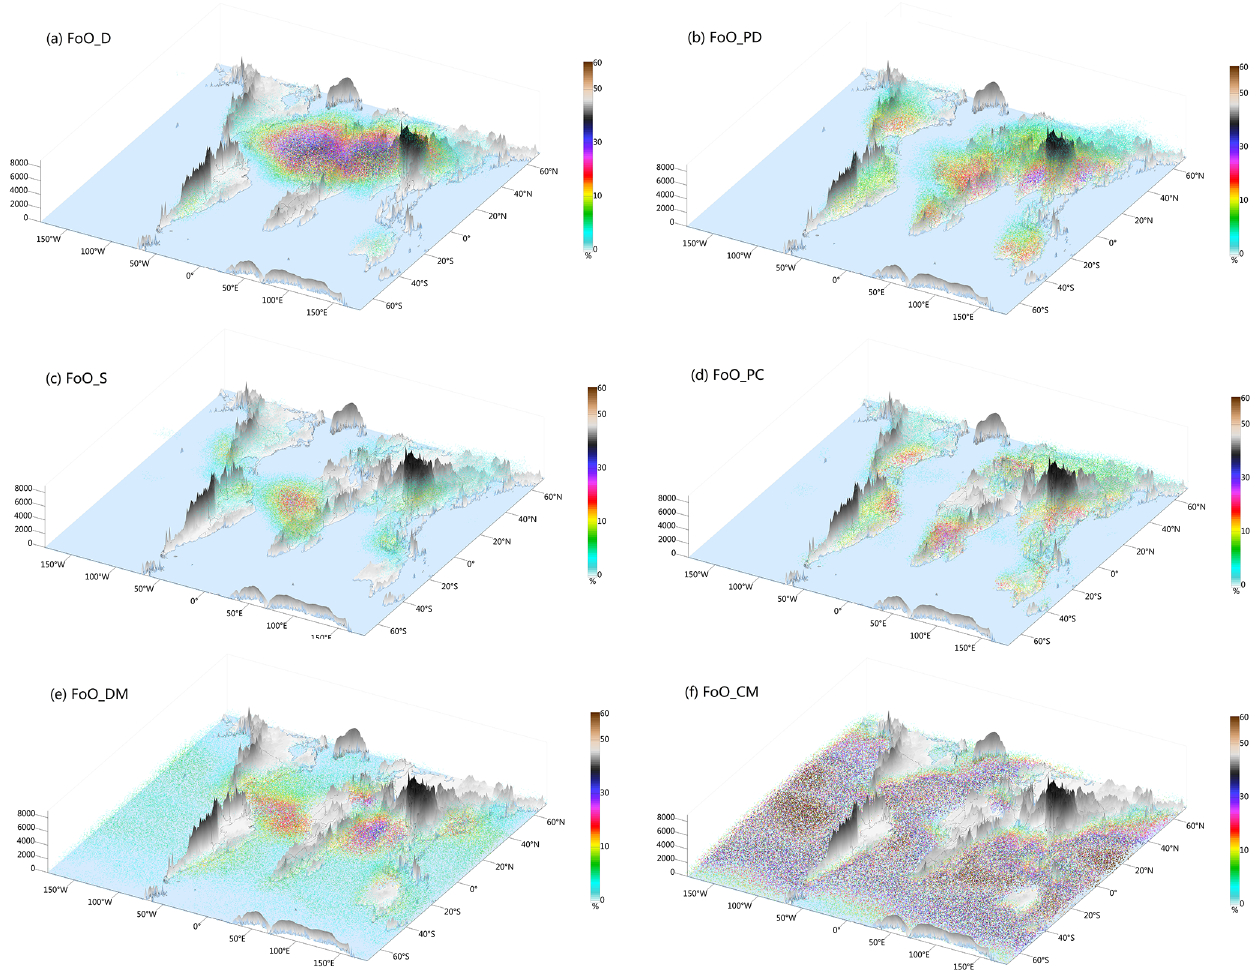
Figure 11. As in Fig. 10 but for type-dependent aerosols: (a) dust; (b) PD; (c) smoke; (d) polluted continental (PC); (e) dusty marine (DM); (f) clean marine